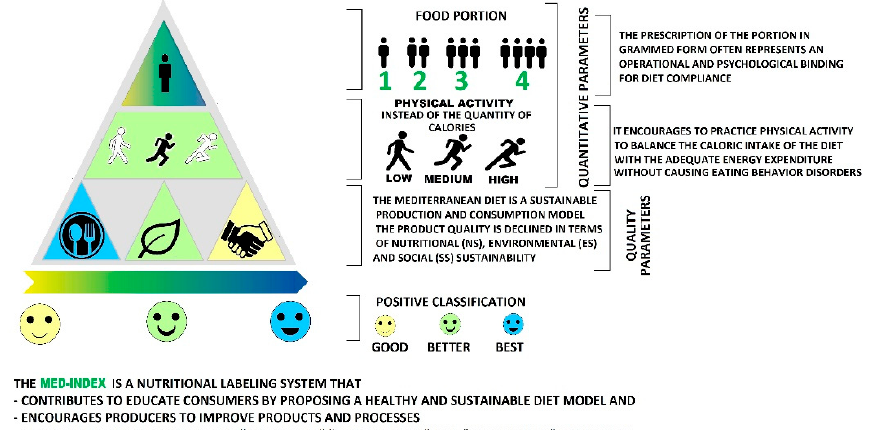
Figure 1. The Med Index—The logo shape: the triangle is the symbol of the food pyramid that evokes the concepts of balanced food choices. The triangle, similarly to the food pyramid, has been divided into three parallel rows returning two fields for quantitative information and one field for qualitative information to the user. The apex and central row of the triangle informs about the number of food portions and the caloric intake of a portion, respectively. It is worth pointing out that listing calories as number of kcal could have a detrimental effect on people with eating disorders; therefore, the caloric intake is expressed in the form of intensity of recommended physical activity(low, medium, and high associated to walking, light running, and intense running, respectively) so that to depict an actual balance between ingested and consumed calories. This approach would allow to inform and educate people to make healthier choices, but without negatively impacting people with eating disorders or those in recovery. Specifically, the caloric intake is deduced from the icon highlighted in black together with the background color: the lowest caloric intake value, associated with walking, is indicated by blue color (symbolizing the best choice), while the high caloric intake value, associated with intense running, is indicated by yellow color (symbolizing the good choice). The color message is always interpretable positively because it starts from the assumption that the Med-Index can only be applied to products that fall within the Mediterranean basket of products. Yellow is the color of optimism and clarity, arousing positive and reassuring emotions; green is the color of freshness, well-being, and relaxation, which expresses authenticity and naturalness and inspires confidence; blue, the color most loved by people, means security, tranquility, and trust.